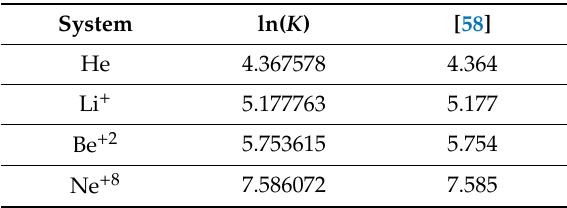
Table 11. Results of ln( K ) for two-electron